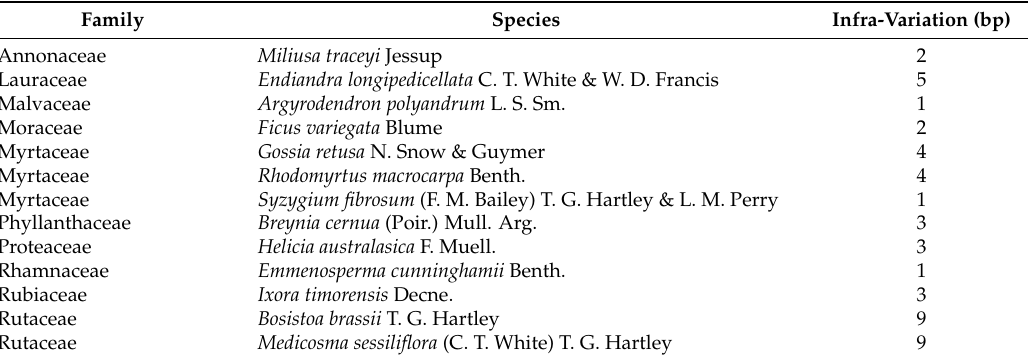
Table 4. List of species showing infraspecific variation across the Normanby Gap. Infraspecific variation (column 3) tallied by total number of base pairs (bp) differences within each species across all three barcode